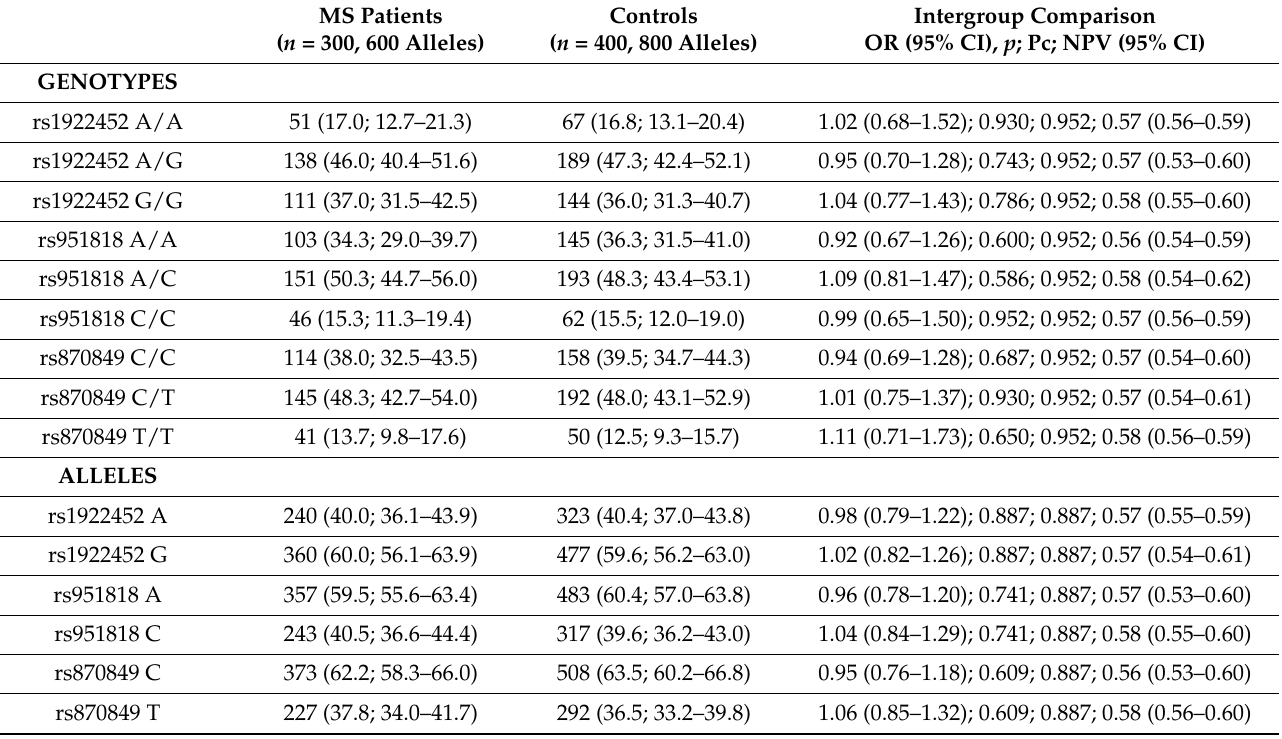
Table 1. Genotypes and allelic variants of patients with MS and of healthy volunteers. The val- ues in each cell represent the number (percentage; 95% confidence intervals). NPV: negative predictive value.